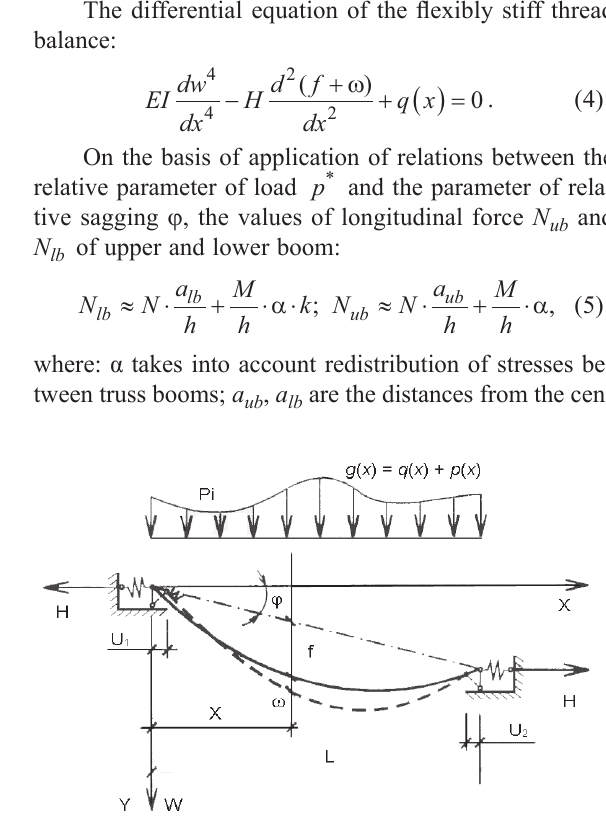
Fig. 2. Flexurally stiff thread design on refractory